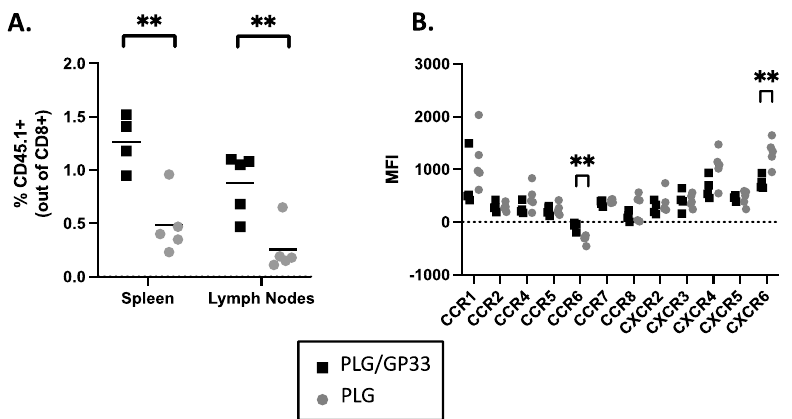
Figure 8. Antigen-loaded nanoparticles induce sequestration of transgenic CD8 + T cells in secondary lymphoid tissues and alter expression of chemokine receptors. Spleens were harvested from P14 transgenic mice ( n = 2 – 3) and CD8 + T cells were isolated by magnetic cell separation, then transferred to recipient C57BL/6 mice. Three days after cell transfer, mice were treated daily for 5 consecutive days with PLG/GP33 or PLG. The numbers of CD45.1 + P14 T cells were determined in spleens or pooled inguinal, axillary, and brachial lymph nodes harvested 24 h after the final treatment. Statis- tical significance was determined by Student’s t -test. ** p < 0.01. ( A ) Cell frequencies were deter- mined by flow cytometry. ( B ) Expression of chemokine receptors on spleen-sequestered cells was determined by geometric mean fluorescence intensity. Data are representative of three repeat ex- periments.